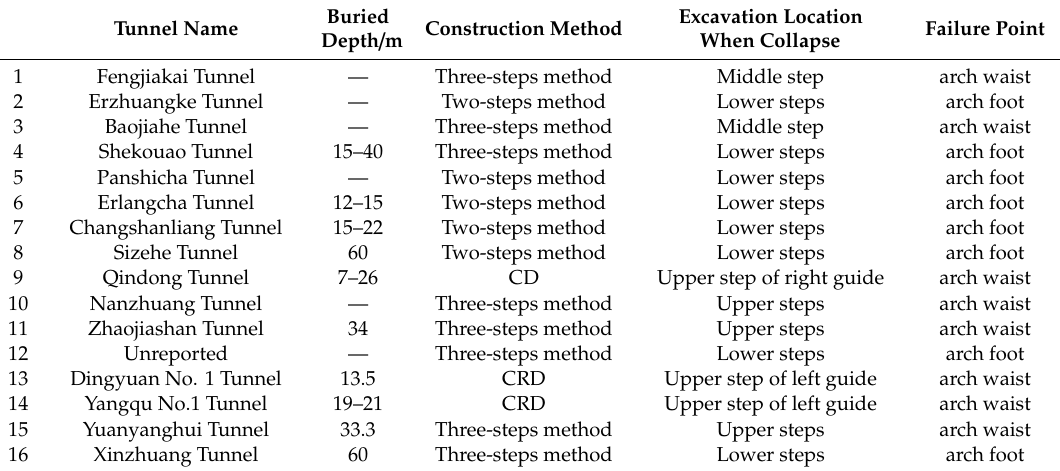
Table 3. Statistics of the stratum bias and the location of the slide surface.